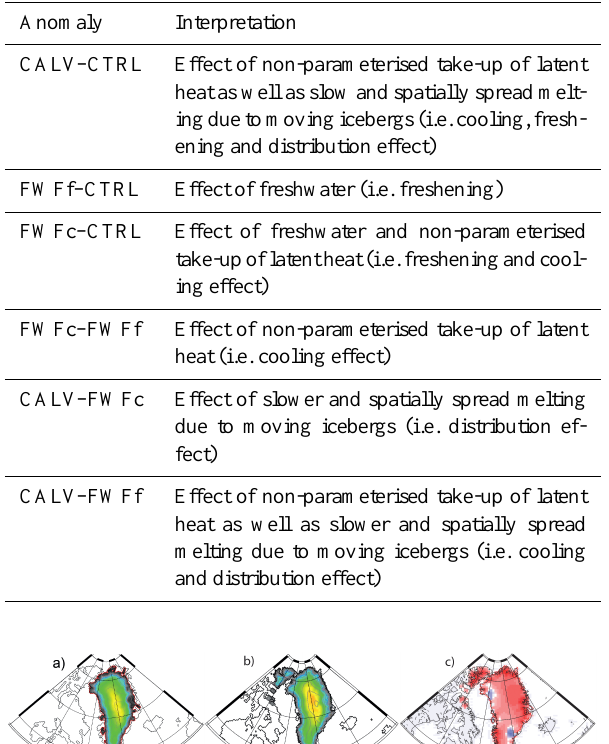
Table 2. Summary of anomalies analysed.